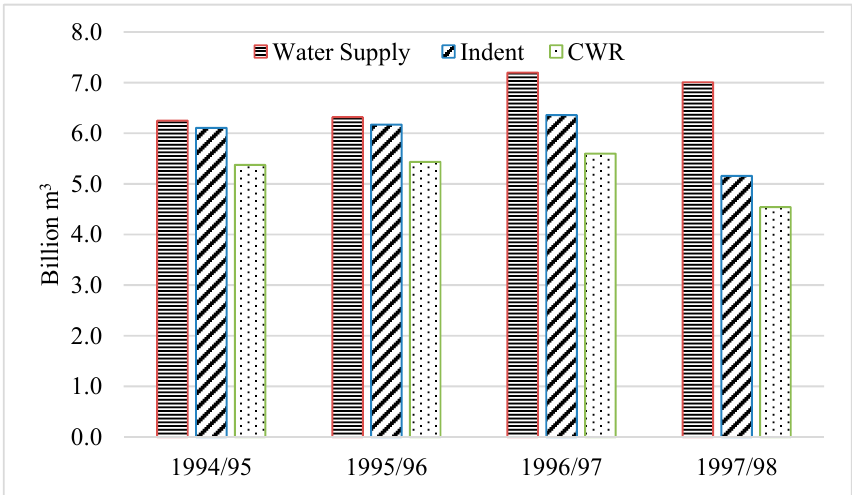
Figure 5. Water supply volume against Indent and CWR at IWC period.